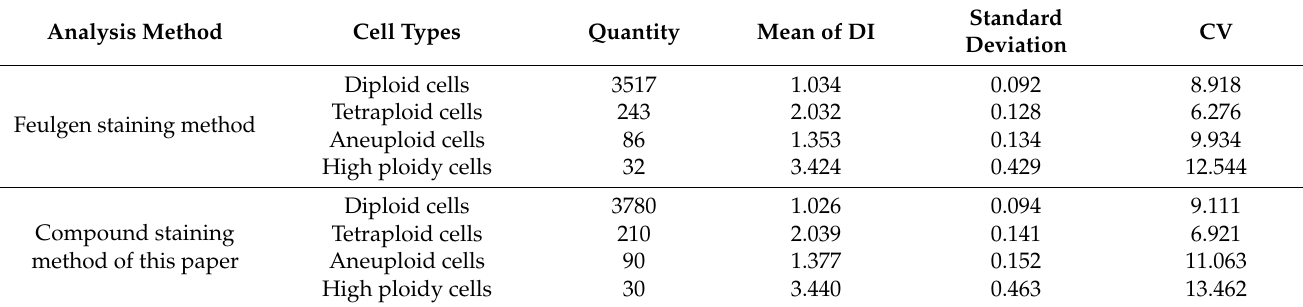
Figure 9. The analysis results of positive case; ( a ) the results of Feulgen-staining method, ( b ) the results of compound-staining method. Table 2. Contrast data of positive case.